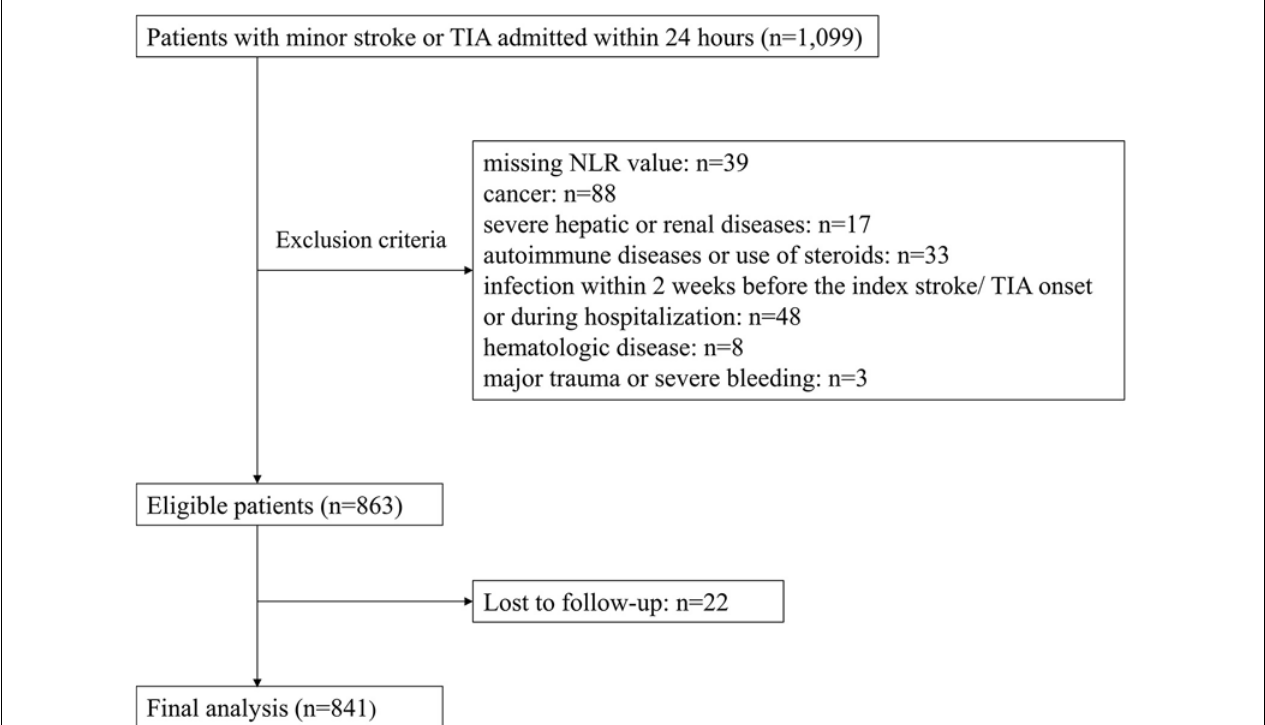
FIGURE 1 | Study flow chart. NLR indicates neutrophil to lymphocyte ratio. TIA indicates transient ischemic attack.